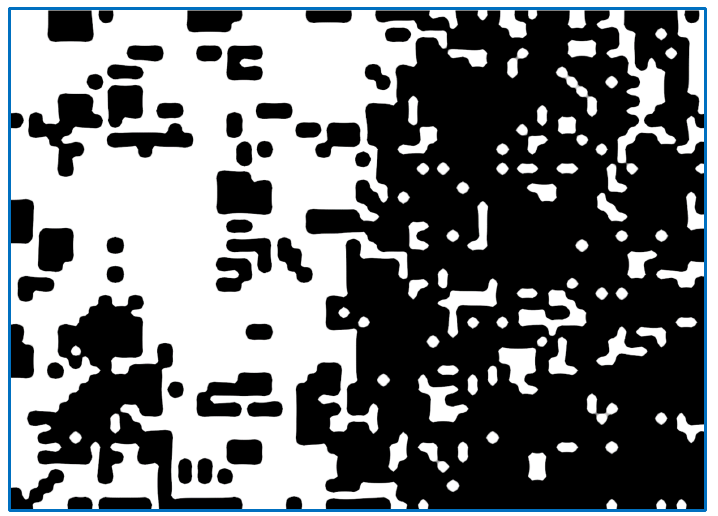
Figure 8. Result highlighting the frequency feature by brightness of a 64 × 64 fragment with 32 pixels step (Equation (9)).